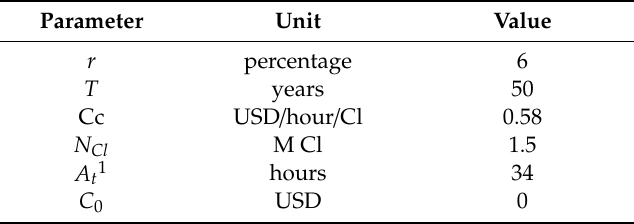
Table 9. NPV parameters